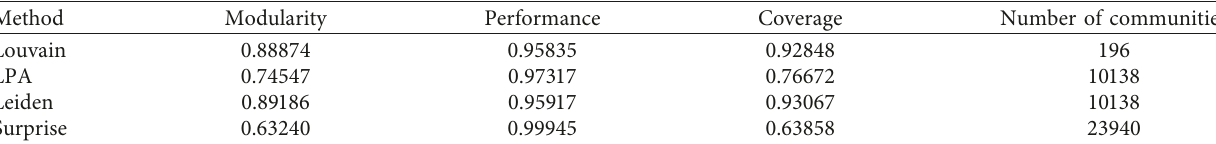
Table 19: For quoting interaction networks from March 11 until May 26 in 2021, useful metrics for evaluation of the community detection algorithms, and number of communities identified in each.